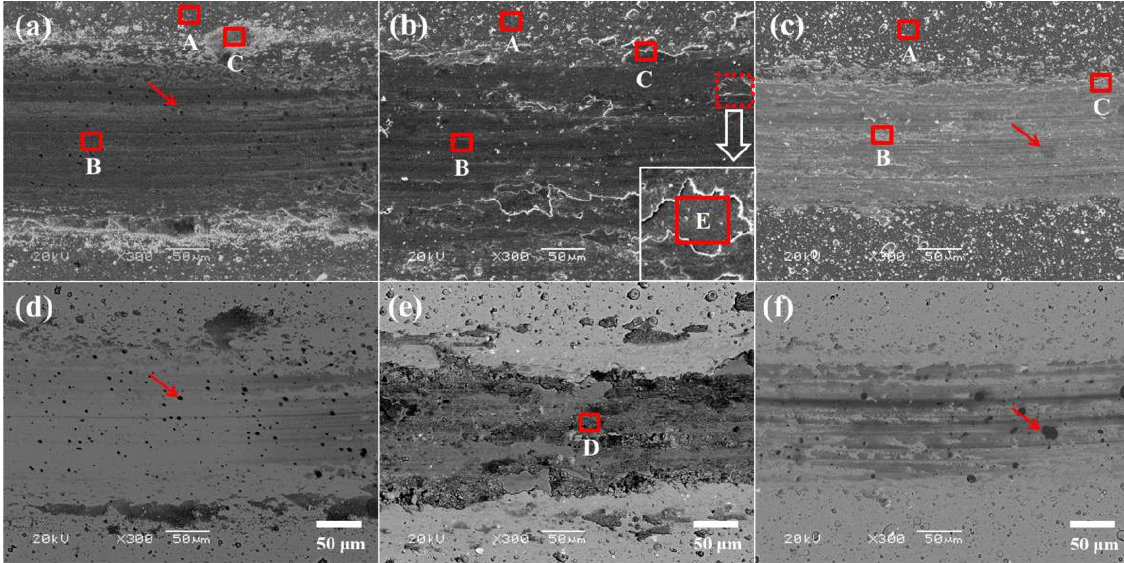
Figure 7. SEM and back-scattering images of worn surfaces for studied films: ( a , d ) NbN; ( b , e ) NbN-Ag; ( c , f ) NbN/NbN-Ag. Table 3. The EDS analysis results for different positions in Figure 7.